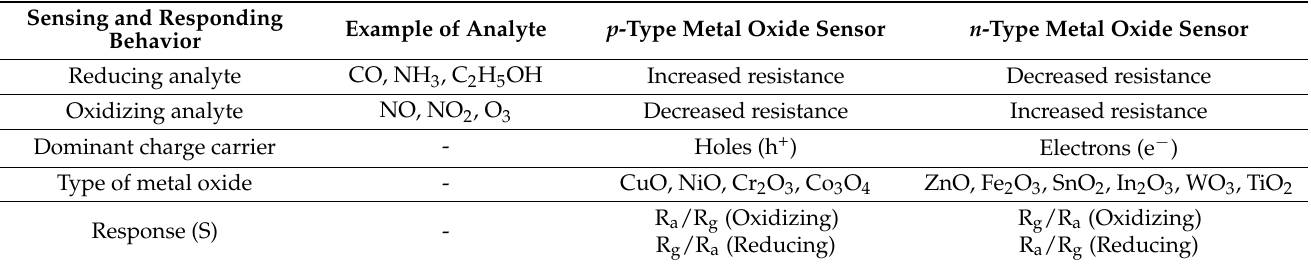
Table 3. Characteristics between n -type and p -type metal oxides toward the analyte.